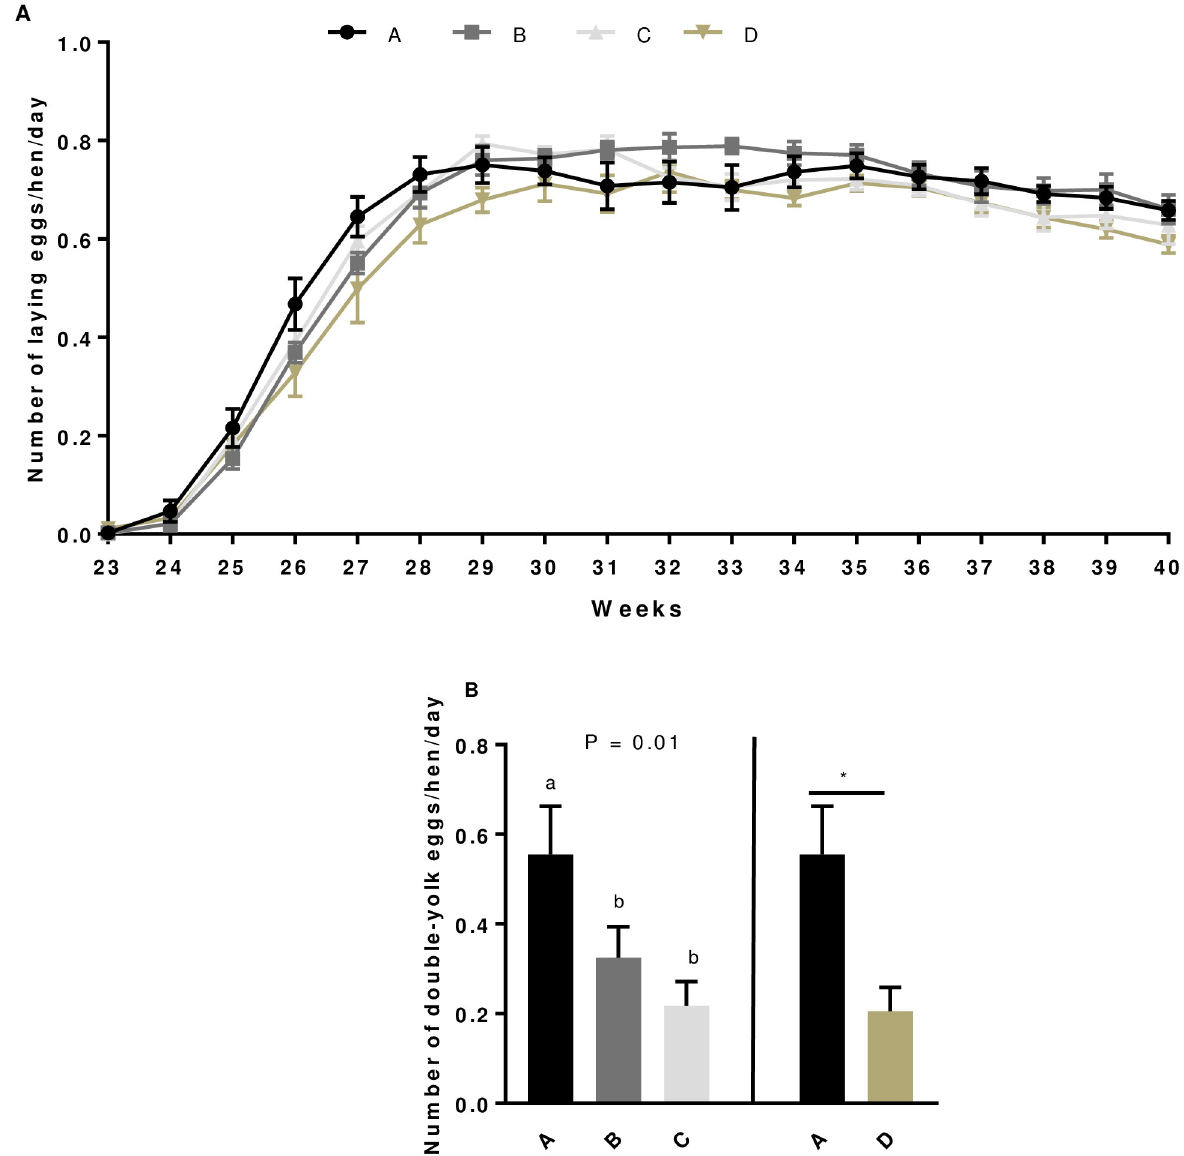
Fig 1. Laying curve (A) and number of double-yolk eggs (B) in broiler hens from 23 rd to 40 th week. Eggs were collected and weighed daily for all hens fed with different concentrations of GSE dietary supplementation or with a control diet. A: animals fed with control diet without GSE supplementation (n = 92), B and C: animals supplemented with GSE at 0.5% and 1% of the total diet composition, respectively, starting at 4 week- old until 40 week-old (n = 80), and D: supplementation with GSE at 1% of the total diet composition starting at hatch until 40 week-old (n = 72). Results are presented as lsmeans ± S.E.M. P values and different individual letters indicate a significant effect of the diet between A, B and C groups or between A and D groups. P value was considered as significant if P <